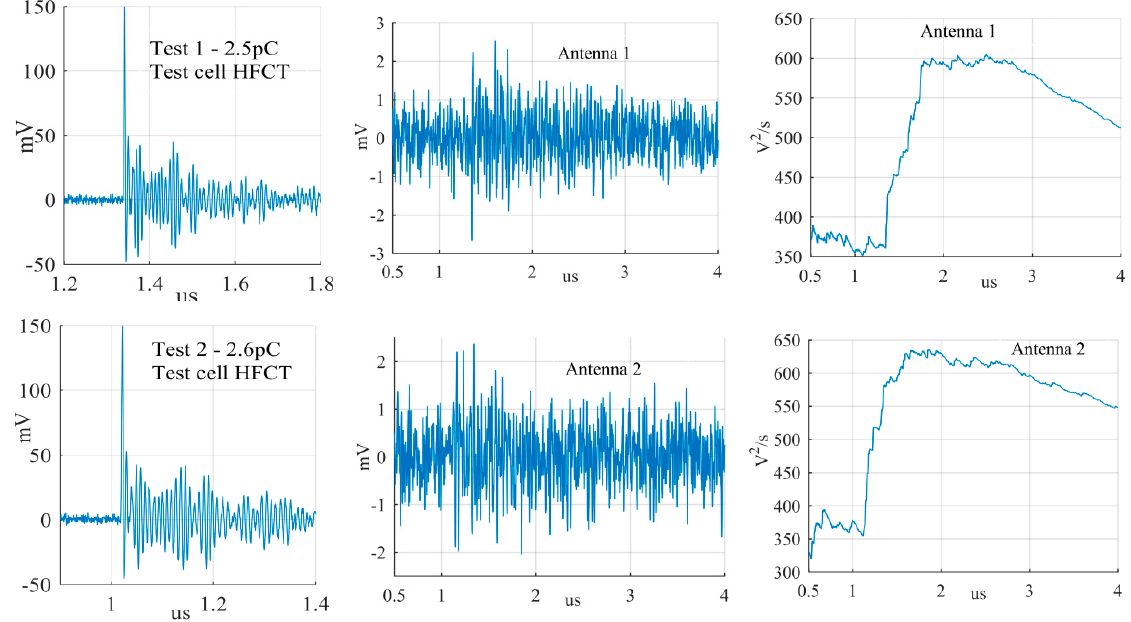
Sensors 2019 , 19 , x FOR PEER REVIEW Figure 16. Smallest surface discharge from the antenna at position 1 and 2. Figure 16. Smallest surface discharge from the antenna at position 1 and 2.